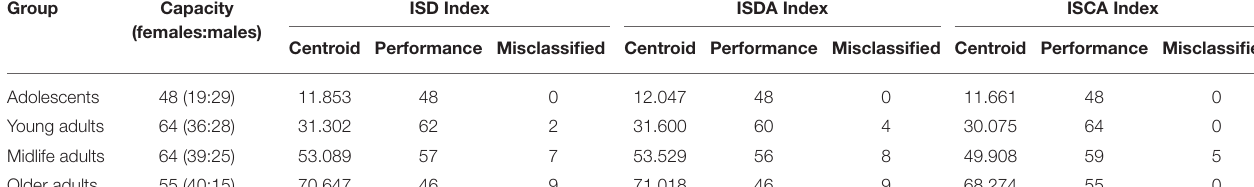
TABLE 2 | Clusterization of the sample into age cohorts with regard to the variables describing the proportion between cognitive functional activities and cooperative involvement of cognitive domains in tasks. Group Capacity ISD Index ISDA Index ISCA Index (females:males)